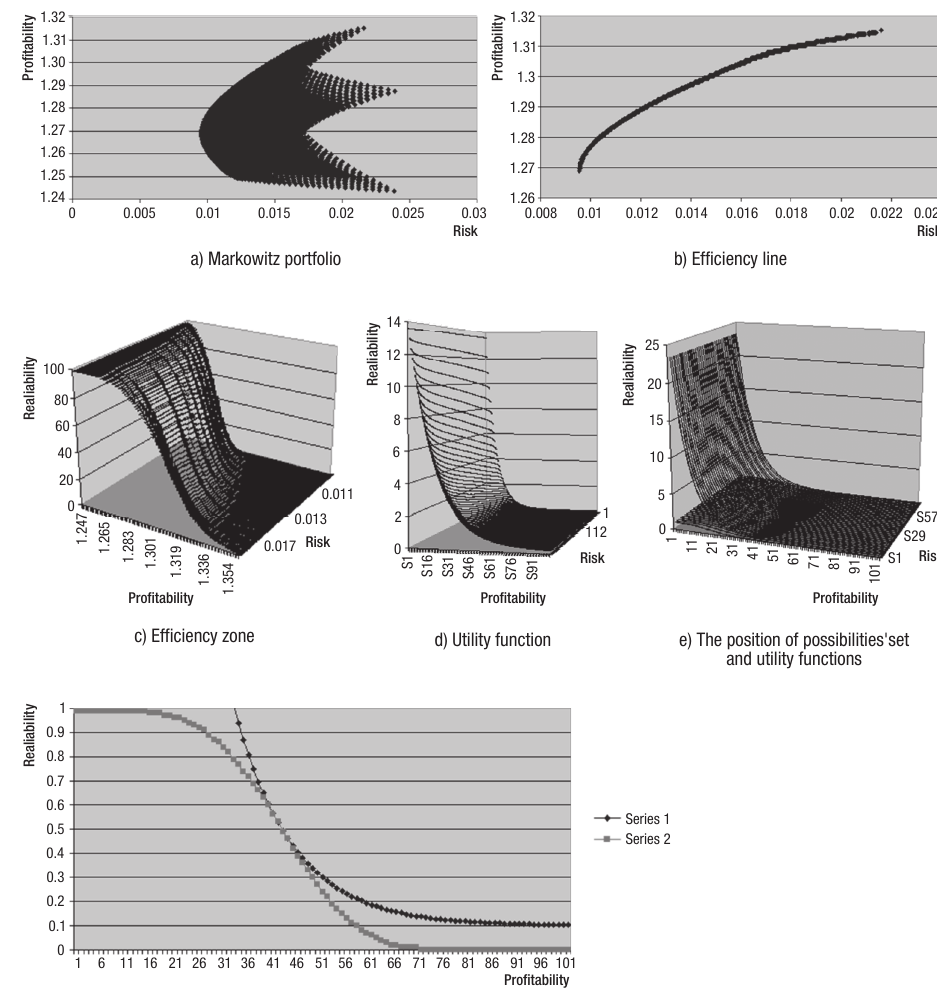
from Table 2 were i and s values, and investment i i were left the i